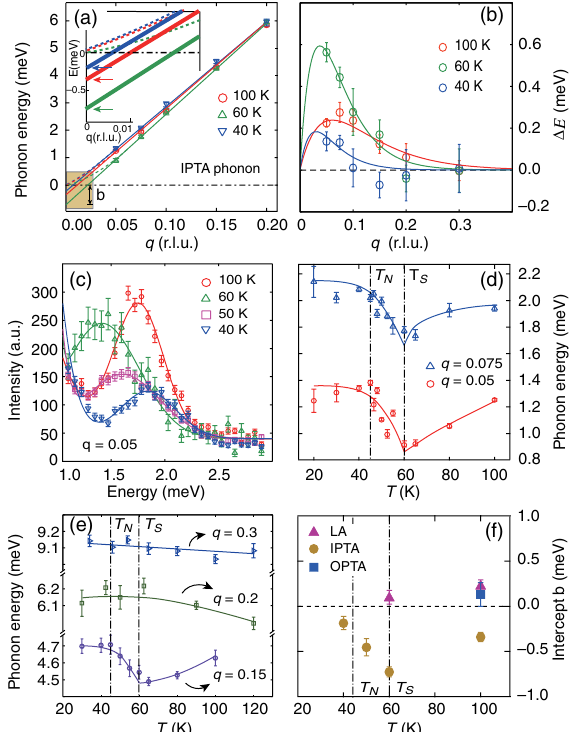
FIG. 2. (a) Temperature dependence of the phonon dispersions of the IPTA mode near the zone center at 100 K, 60 K, and 40 K. The inset shows the expanded view of the low-energy part of the dispersions. (b) The estimated amplitude of the softening of the IPTA phonons at difference temperatures obtained by subtracting an assumed linear dispersion E ¼ vq . The solid lines are guides to the eye. (c) Temperature dependence of constant- q scans at q ¼ 0 . 05 for the IPTA mode. (d,e) Temperature dependence of the phonon energy measured at q ¼ 0 . 05 , 0.075 and 0.1,0.15, respectively. The phonon softening on cooling to T s is observed at q ¼ 0 . 05 , 0.075, and 0.15 r.l.u. but absent at q ¼ 0 . 20 and 0.3 r.l.u. The phonon hardening below T s is seen for wave vectors below q ¼ 0 . 2 r.l.u. (f) Temperature dependence of the intercept b estimated for all three acoustic branches shown in Fig.